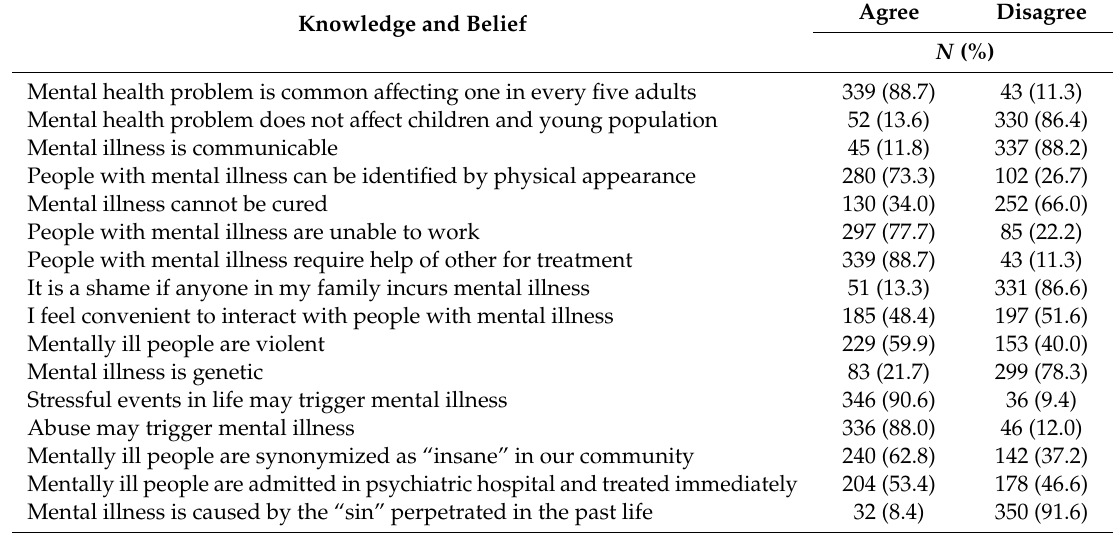
Table A1. Knowledge and belief on mental illness and related